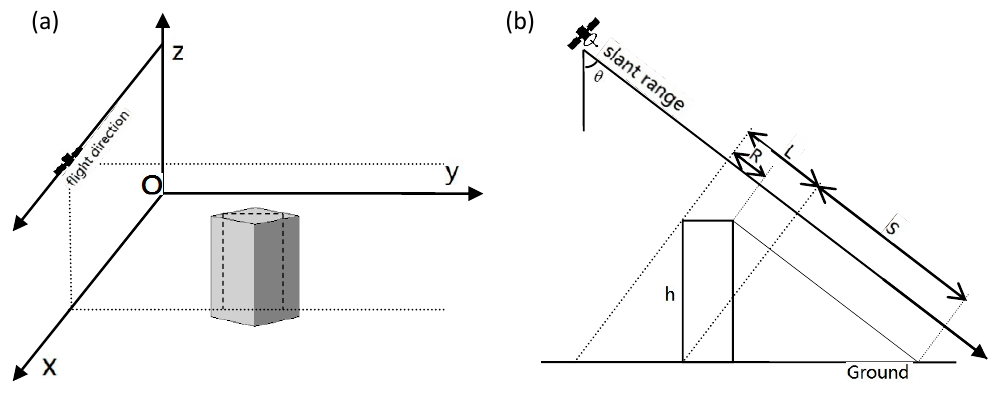
Figure 2. Building in the oblique side-looking imaging geometry of SAR sensors: ( a ) O-xyz coordinate system; and ( b ) building features in the slant range of a SAR image. L: Layover; R: Roof; S: Shadow; H: Height.